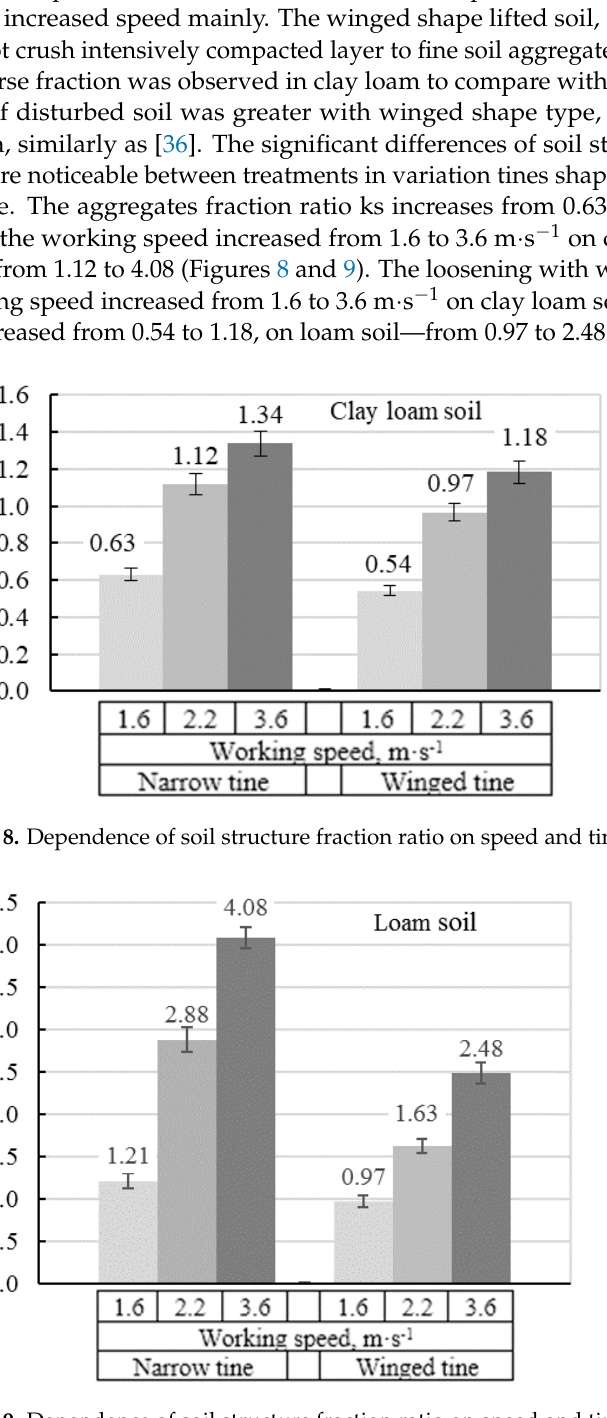
Figure 9. Dependence of soil structure fraction ratio on speed and tine types loam soil.